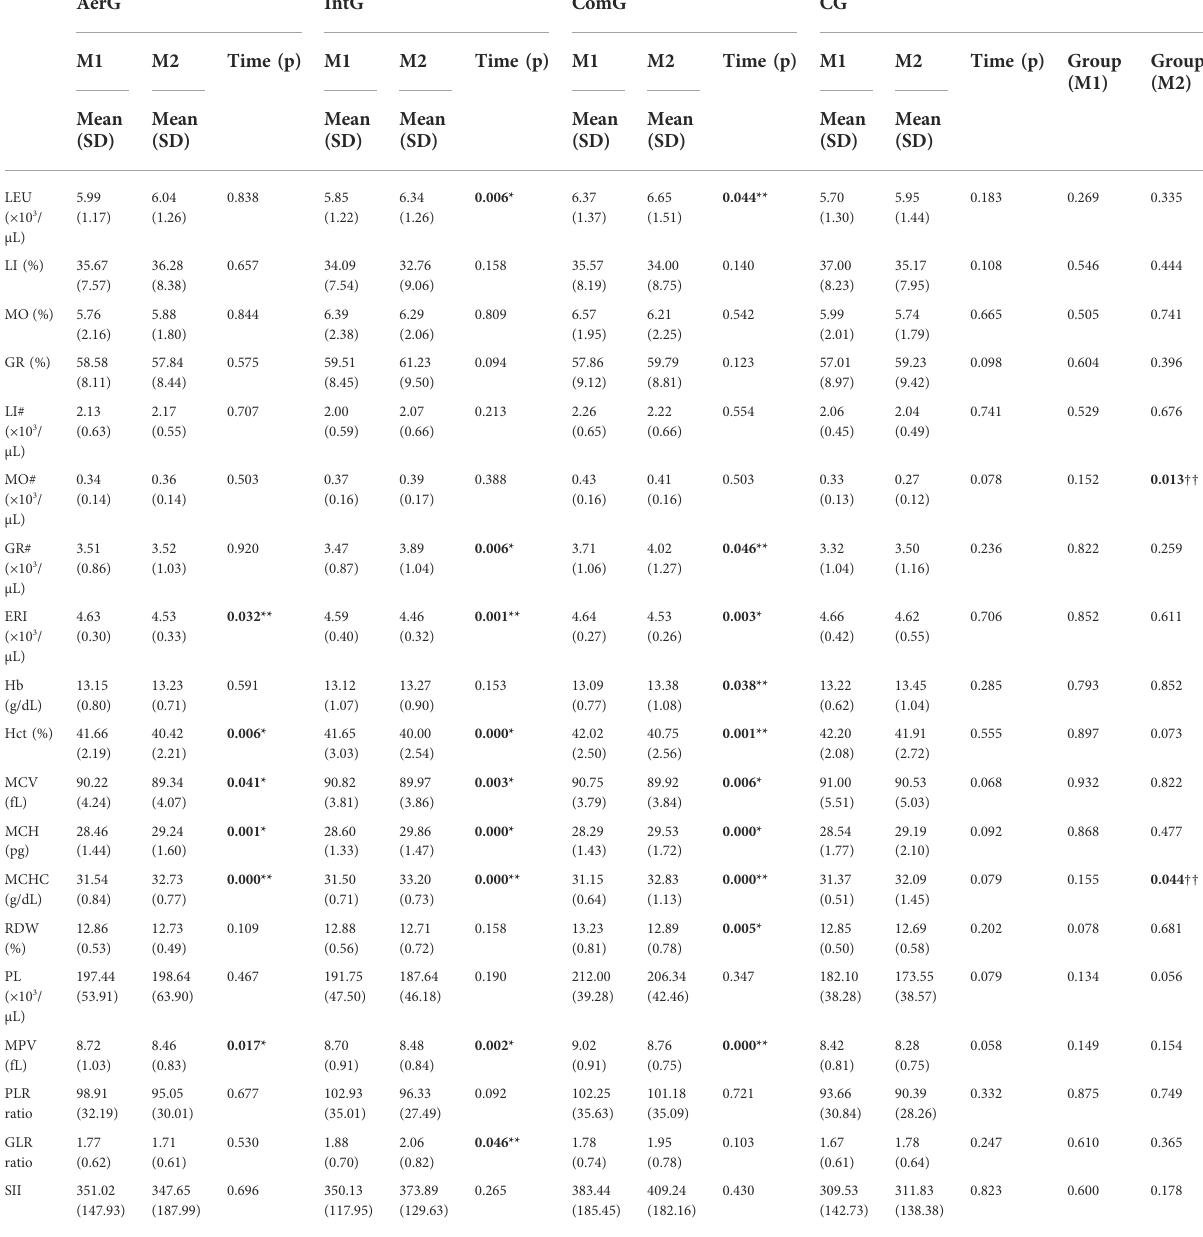
TABLE 2 Results of systemic hematological variables at baseline and after 28 weeks of